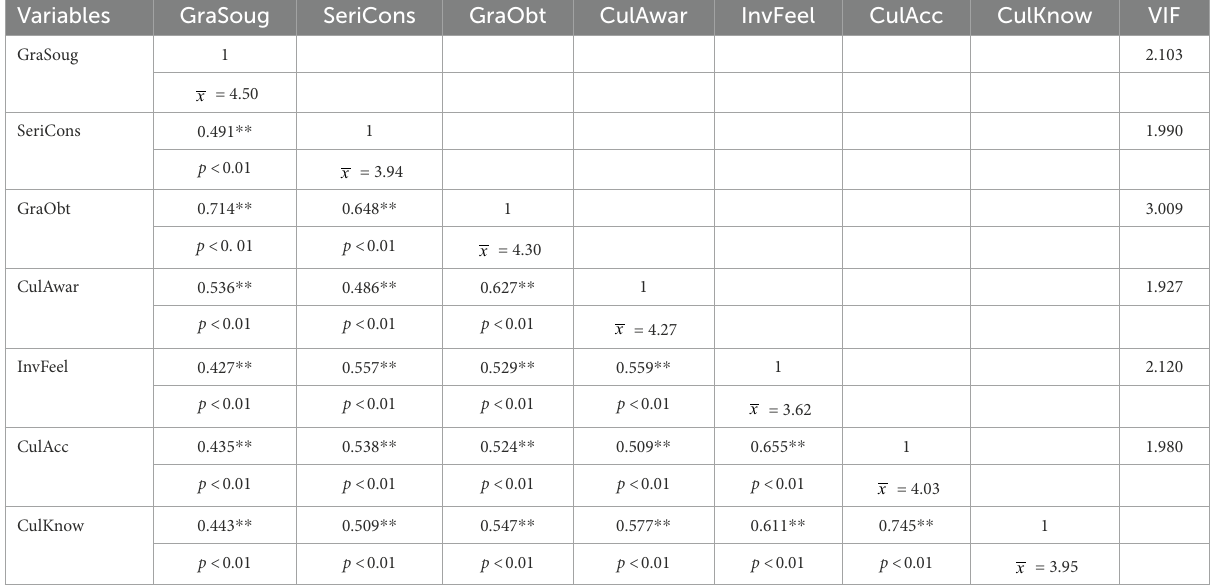
TABLE 2 Correlation analysis.